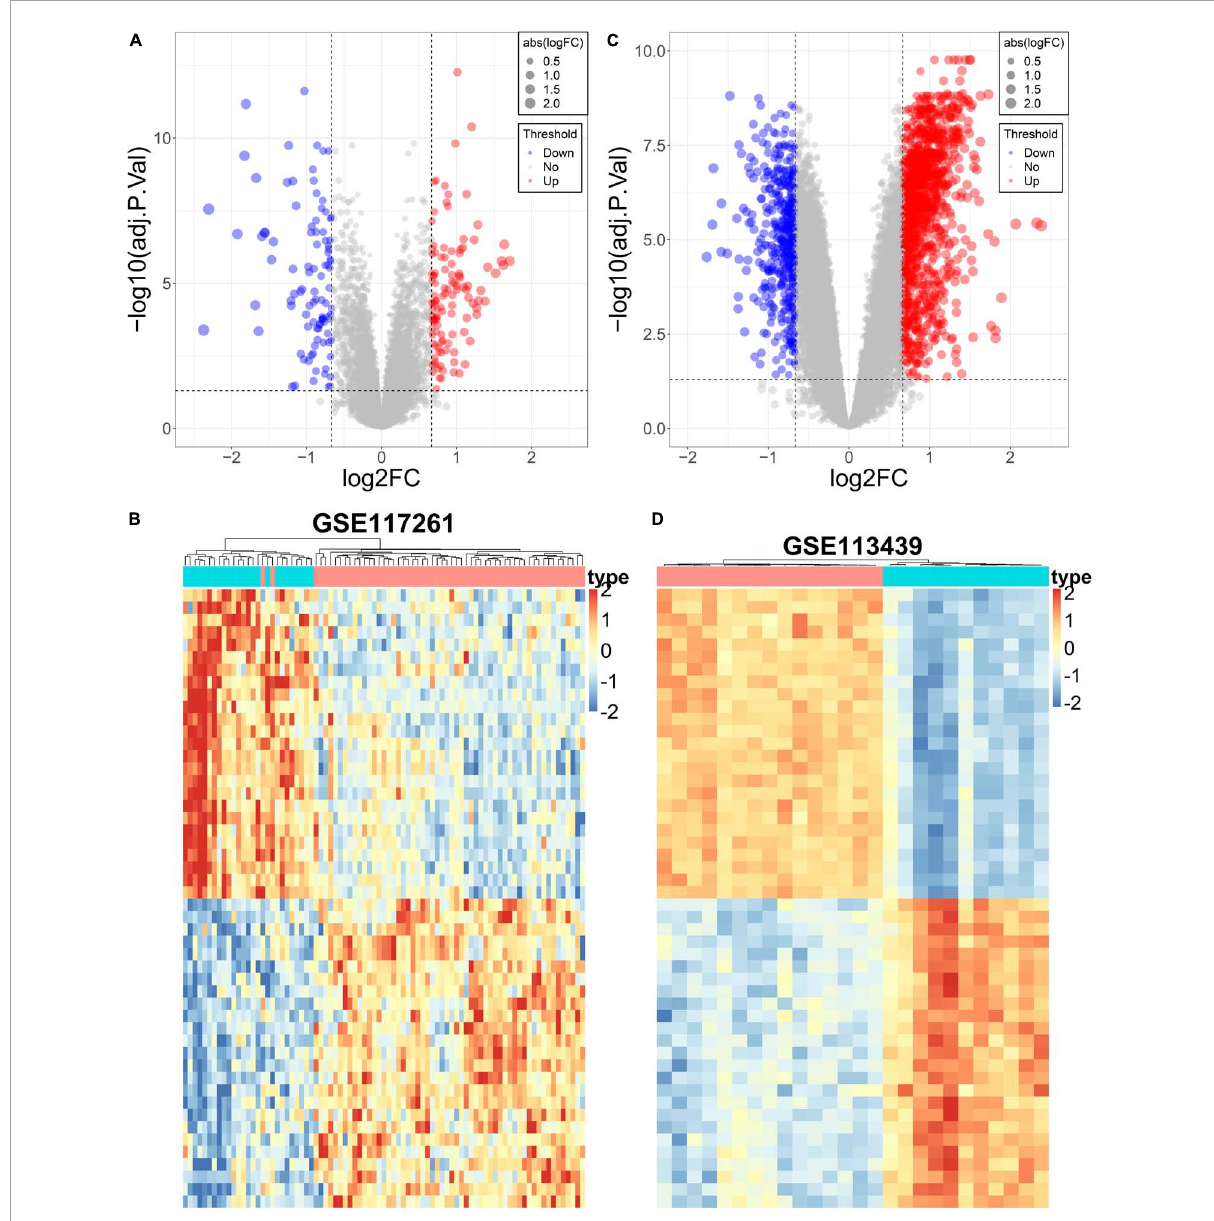
FIGURE4 Differential expression analysis of the PAH datasets. (A) The volcano plot of DEGs in GSE117261. (B) The heatmap of DEGs in GSE117261. (C) The volcano plot of DEGs in GSE113439. (D) The heatmap of DEGs in